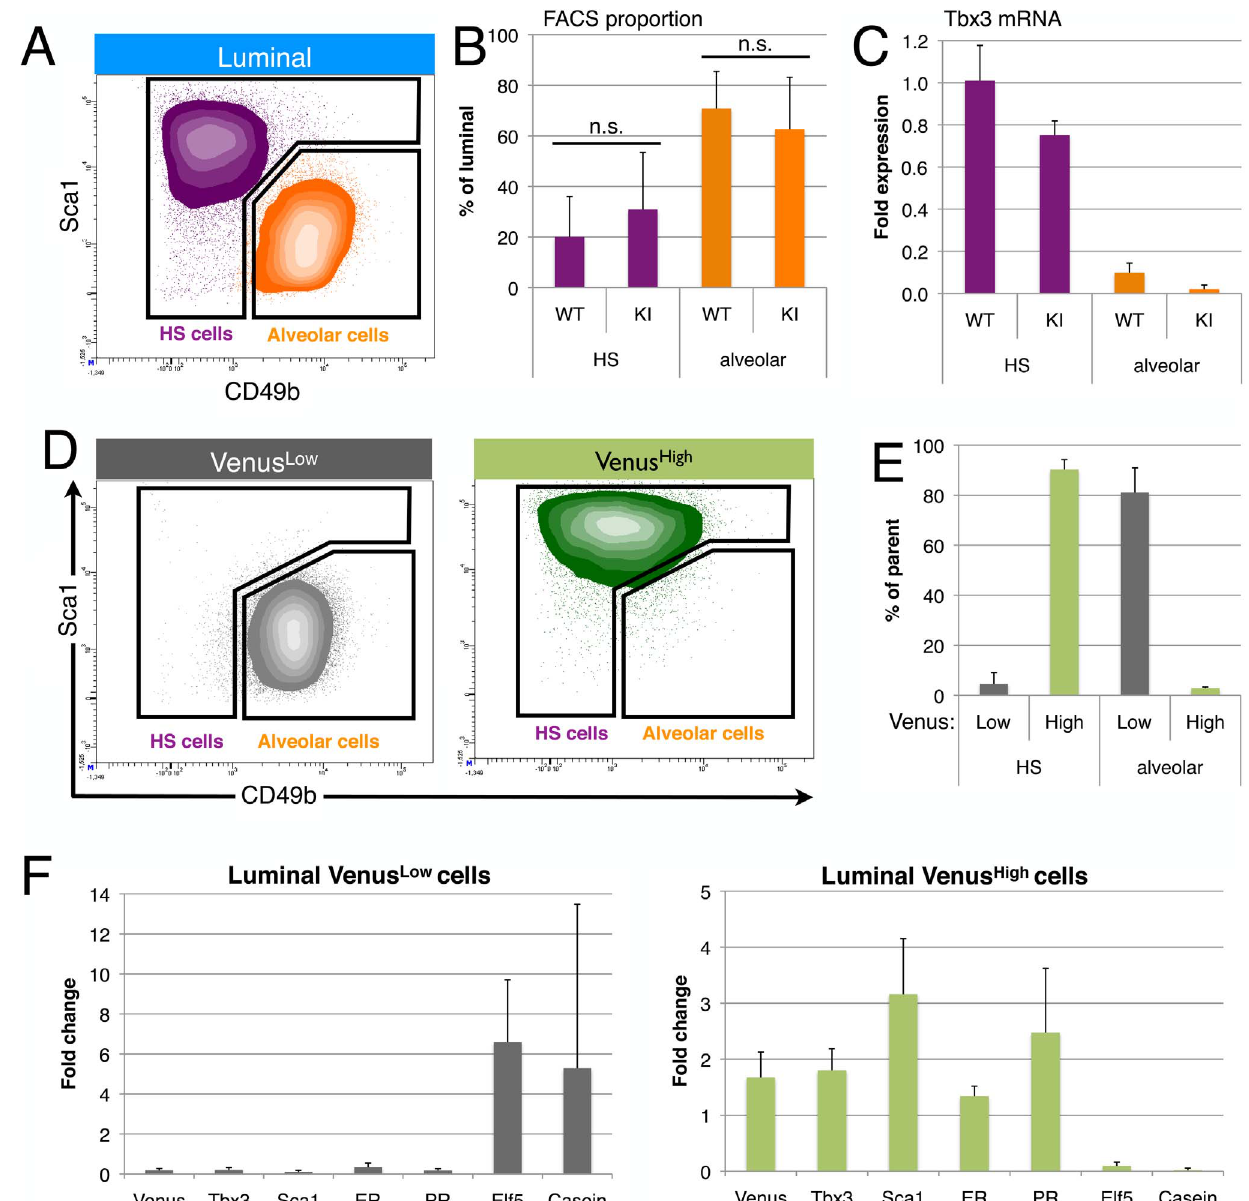
Figure 2. Tbx3 marks hormone sensing cells. (A) Luminal cells from wildtype mammary glands are separated into hormone-sensing (HS, Sca1 hi CD49b lo , purple) and alveolar (Sca1 l u CD49b hi , orange) subsets based on Sca1 and alpha2-integrin (CD49b) expression. (B) There is no significant (n.s.) difference in the proportion of hormone-sensing (HS, purple) and alveolar cells (orange) between Tbx3 + / + (wildtype, WT) and Tbx3 + /Venus (Knock- in, KI), paired t-test p=0.53 for HS and p=0.60 for Alv. (C) Tbx3 mRNA levels in sorted populations as indicated. (D) Tbx3 + /Venus luminal cells were first gated for Low or High Venus expression (see Figure 1D), and then plotted based on Sca1 and CD49b expression. (E) Proportion of hormone-sensing (HS, purple) and alveolar cells (orange) that are Venus Low (grey) or Venus High (green), measured by FACS in 3 independent Tbx3 + /Venus animals. (F) Fold change in mRNA expression in luminal Venus Low (left panel) or Venus High (right panel) cells, relative to total luminal population. Data are presented as mean 6 SD of three adult virgin Tbx3 + /Venus animals.